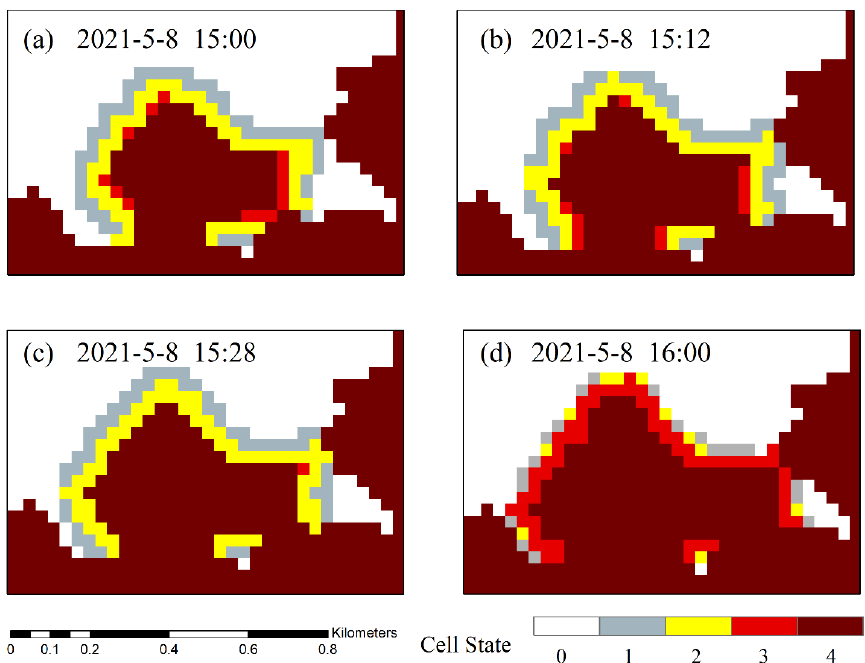
Figure 9. Predicted forest fire spread simulation map for 2021.5.8 15:00–16:00: ( a ) traditional CA model simulation graph for 8 May 2021, at 15:00; ( b ) adaptive CA model simulation graph for 8 May 2021, at 15:12; ( c ) adaptive CA model simulation graph for 8 May 2021, at 15:28; ( d ) traditional CA model simulation graph for 8 May 2021, at 16:00.